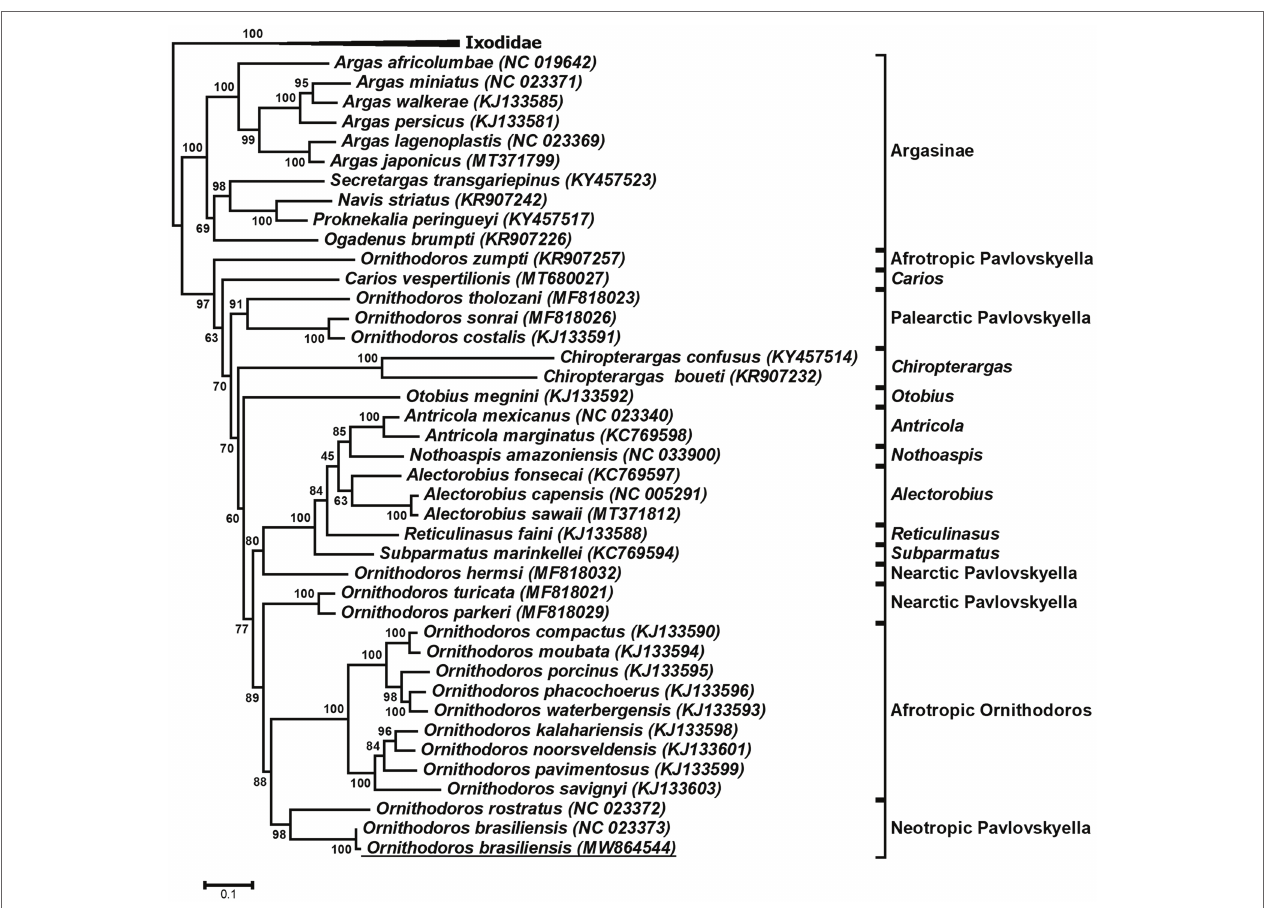
FIGURE 3 | Phylogenetic analysis of argasid mitochondrial genes. Indicated is a maximum-likelihood tree of the protein coding genes COI, CYTB, ND1, ND2, and ND4 of the mitochondrial genome. Bootstrap values for 1,000,000 bootstraps are indicated. The tree was rooted with the Ixodidae. The mitochondrial genome obtained in the current study is